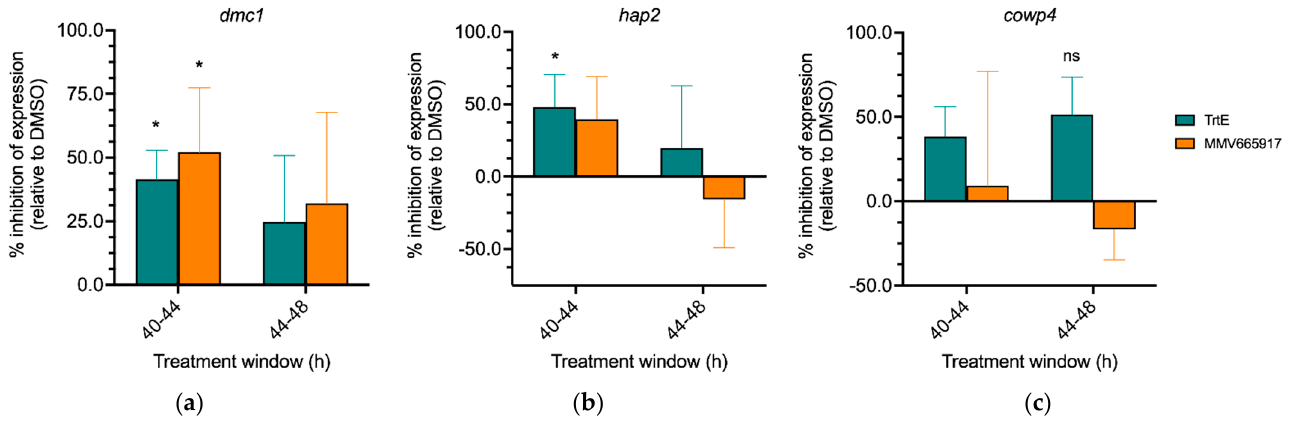
Figure 6. TrtE targets early sexual stages of Cryptosporidium . C. parvum infected cells were treated with DMSO, trtE or MMV665917 for 4 h at 40, and 44 hpi. RNA was isolated and RT-qPCR was used to quantify the relative expression of ( a ) DMC1 , ( b ) HAP2 and ( c ) COWP4 . The human actin gene was used as the reference gene. Data plotted are the mean percent inhibition of expression relative to DMSO control based on 2 – ∆∆ Ct values of three biological replicates run in triplicate ± S.D. Means were determined to be different from 0 using two-way ANOVA with two-stage linear step-up procedure of Benjamini, Krieger and Yekutieli for multiple comparisons correction, * p < 0.05; ns = not significant ( p = 0.0645).